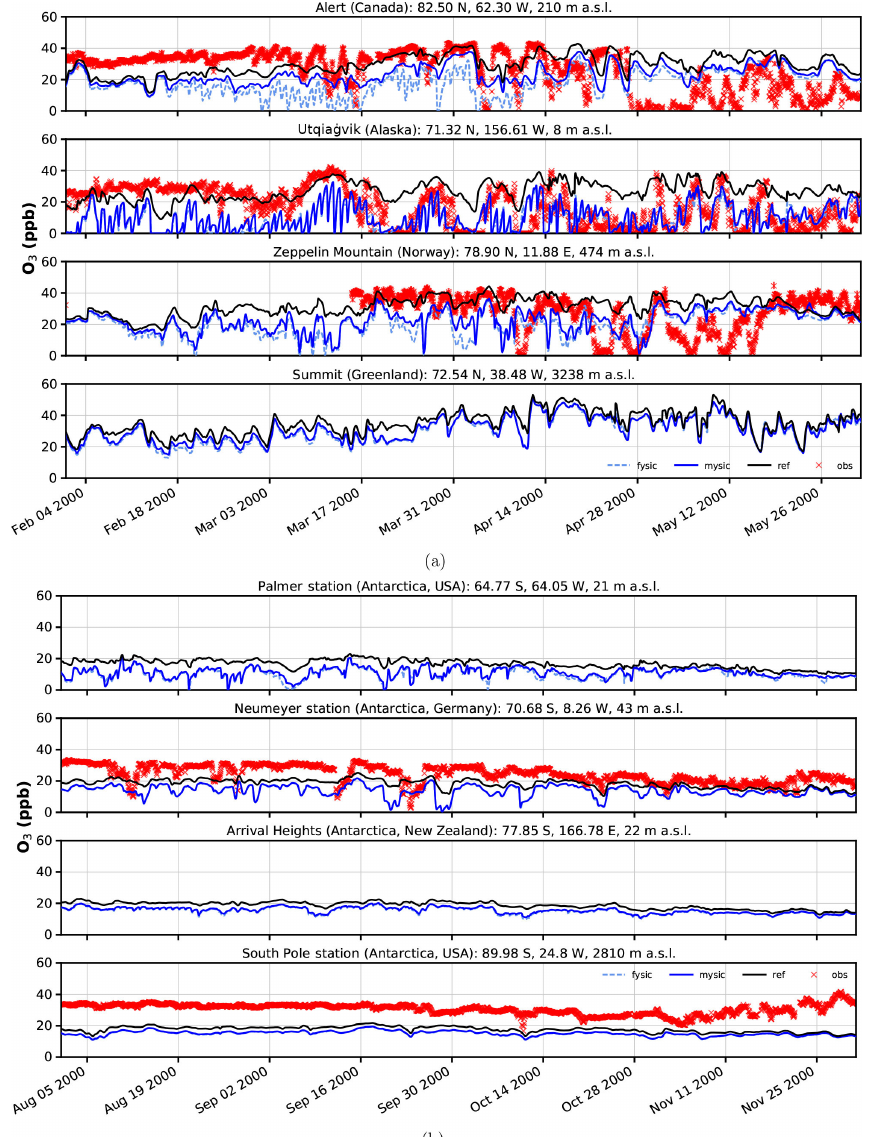
Figure 6. Surface ozone mixing ratios at four different observation sites for spring and austral spring, respectively. Comparison of in situ measurements (red crosses) with results from simulation (solid black – EMAC v2.52 default (no bromine explosions); light blue dashed – FYSIC; solid blue – MYSIC). Representatively, the nearest grid point has been chosen. (a) Northern Hemisphere; (b) Southern